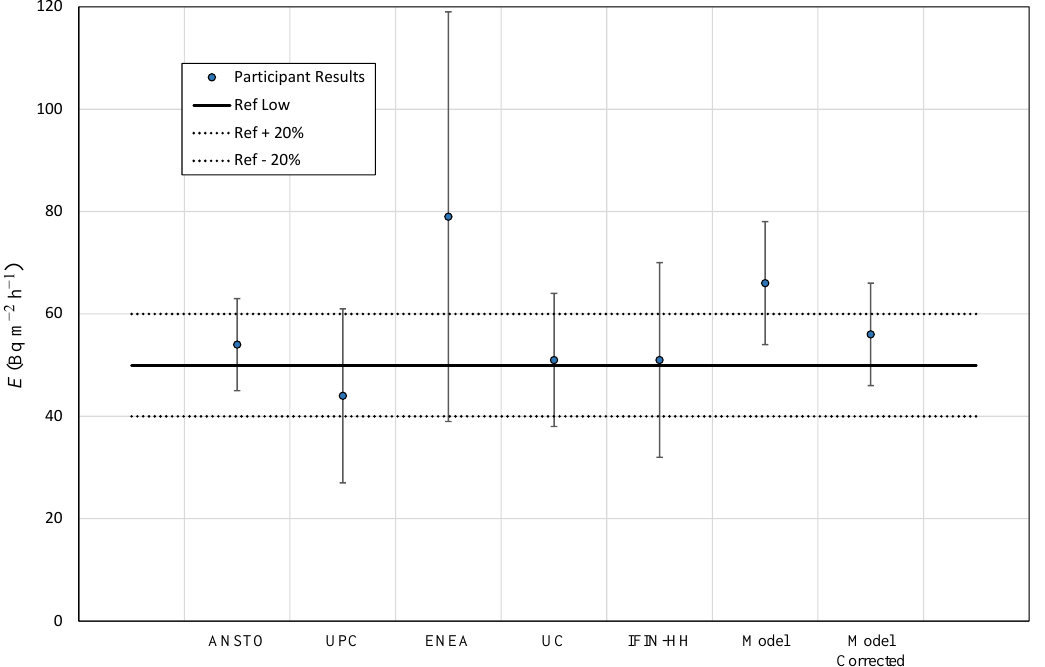
Figure 14. Participants results: average and reference value for the low radon flux area campaign.